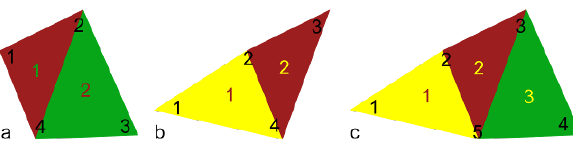
Figure 2. Mesh 1 with according numbering (a), second mesh with own numbering of triangles and vertices (b). Combined datasets with superior numbering